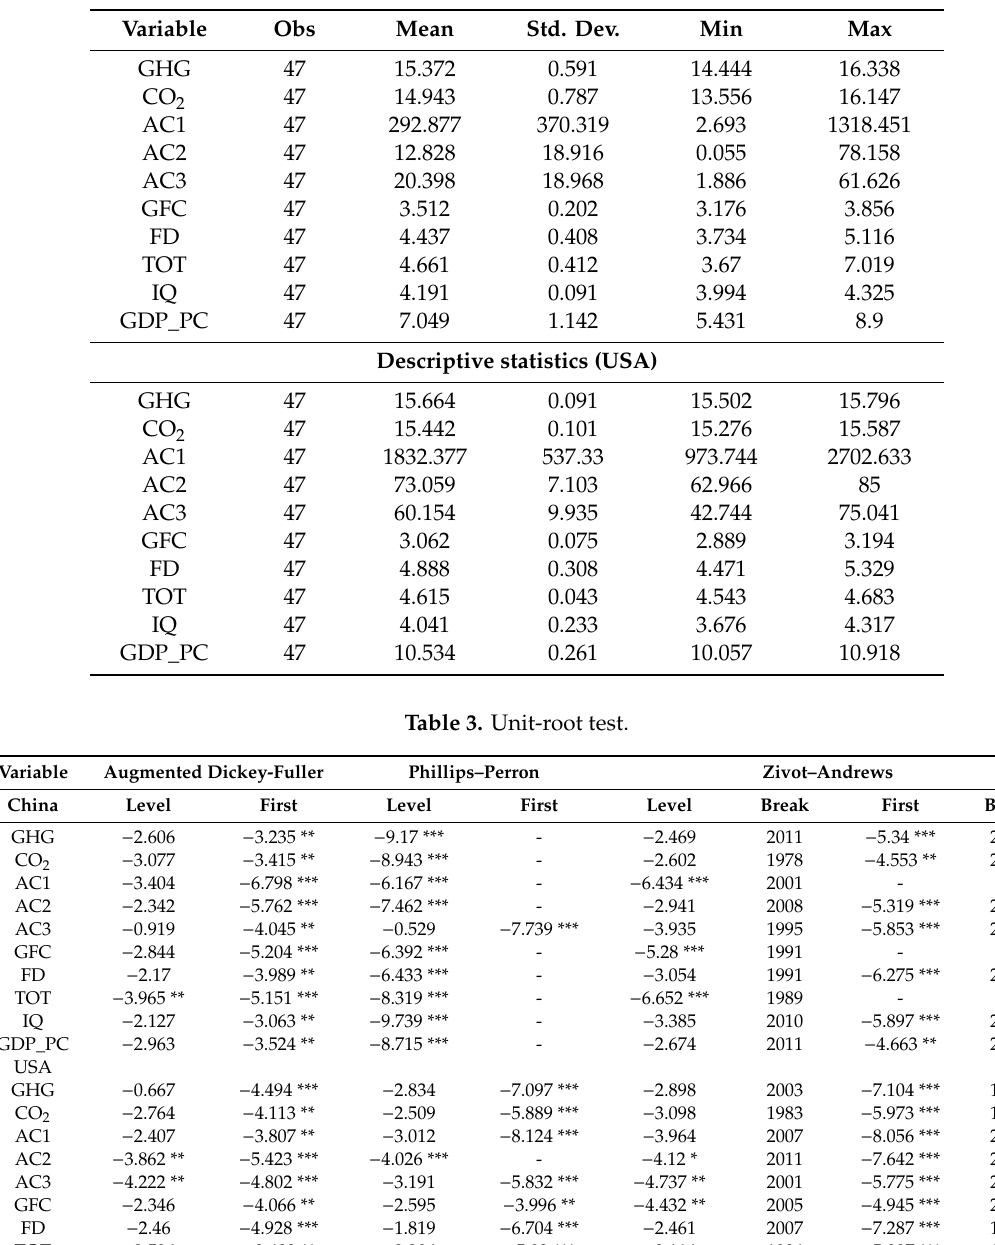
Table 2. Descriptive statistics (China).